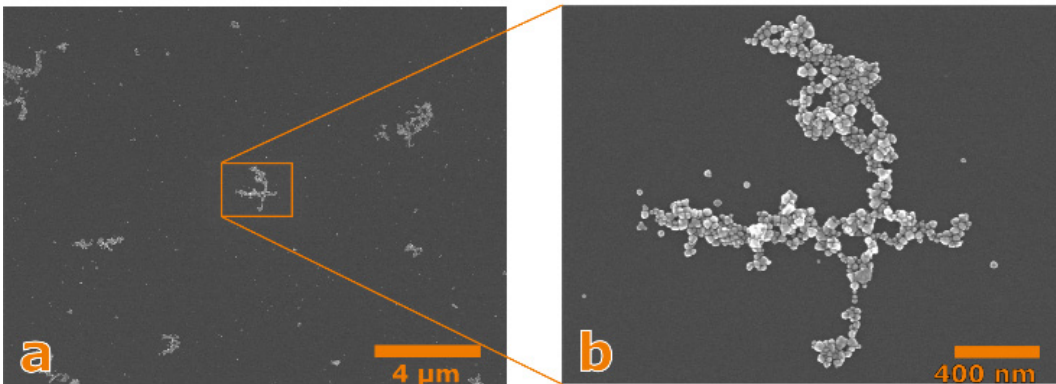
Figure 4. Formation of larger filamentous gold nanoparticle aggregates by the reduction of HAuCl 4 (50 µ M) with ascorbic acid (100 µ M) in the presence of poly-DADMAC (5 ppm): ( a ) SEM image showing several aggregates, ( b ) SEM imaging showing one filamentous aggregate at enhanced magnification.